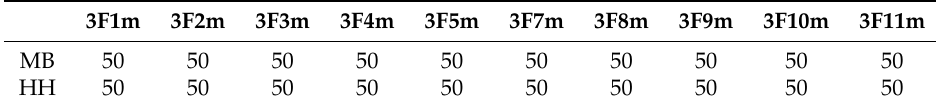
Figure 6. Noise sources and the receiver arrangement for generating and recording new inter-floor noises. Table 5. The number of data in the new inter-floor noise dataset for 2 types of noise sources at 10